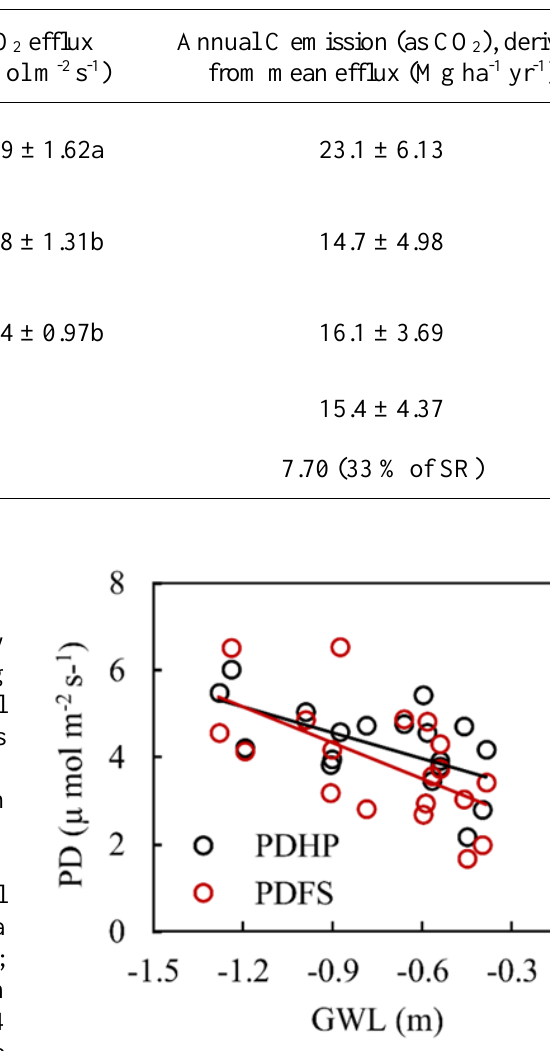
Figure 4. Relationship between peat decomposition (PD) and groundwater level (GWL) on different management areas: peat decomposition in the harvesting path (PDHP, black circle) and peat decomposition in the frond stack (PDFS, red circle). Each symbol denotes an average of 3 plots ( n = 3). A line is fitted for each management area ( p < 0.01). PDHP (black line): y = -1.99x + 2.77 ( r 2 = 0.34), and PDFS (red line): y = -2.78x + 1.84 ( r 2 =